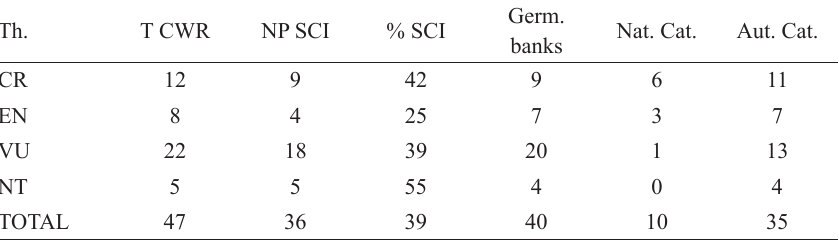
Table 3. In situ , ex situ and legal conservation status of target CWR species of Spain (T CWR). For abbreviations on the rest of variables see Table 2. Th. T CWR NP